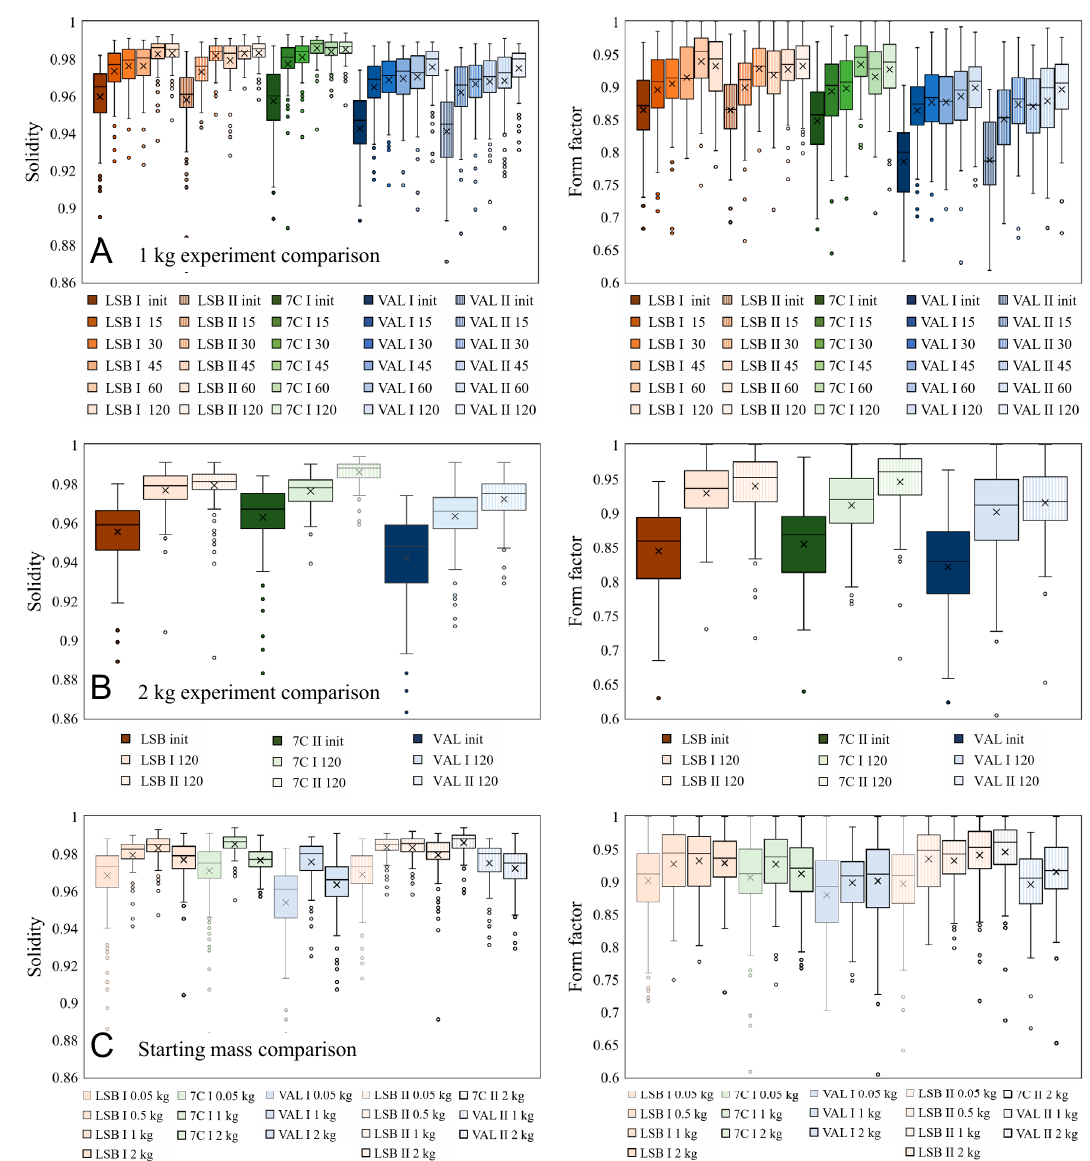
Figure 5: Shape evolution of clasts as function of experimental conditions. Box plots showing the distribution of solidity (left-hand panels) and form factor (right-hand panels). Shape factors for clasts tumbled for increasing tumbling duration are shown in progressively lighter shades (trailing numbers in the legend refer to the tumbling duration in minutes, and ‘init’ is the initial material). Type I and II experiments are shown as solid and striped boxes, respectively. The 25–75 % range of the data is shown in the coloured boxes, the median is marked with a horizontal line and the mean is indicated by a cross. The whiskers extend up to 1.5 times the box range. Data falling outside this range are possible outliers and shown as coloured dots. [A] Data for multi-step experiments with 1 kg starting weight. For all five sample sets, the change in the shape factors is highest between initial material and clasts after 15 minutes tumbling. Pumice samples (LSB, 7C) achieve maximum values after 30 to 60 minutes of tumbling, indicating a high propensity for abrasion. Scoria samples (VAL) show linear changes between 15 and 120 minutes, indicating continued rounding at quasi-constant rates. [B] Shape characteristics of starting material and final clasts after 120-minute experiments with 2 kg starting weight. All samples (apparently minor for LSB) exhibit enhanced shape changes when ash is left out after each time interval. [C] Shape factors of LSB clasts following 120 minutes of tumbling with varying starting weights are plotted. The e ff ect of static load at the drum base and the number of simultaneous clast-clast rotations is